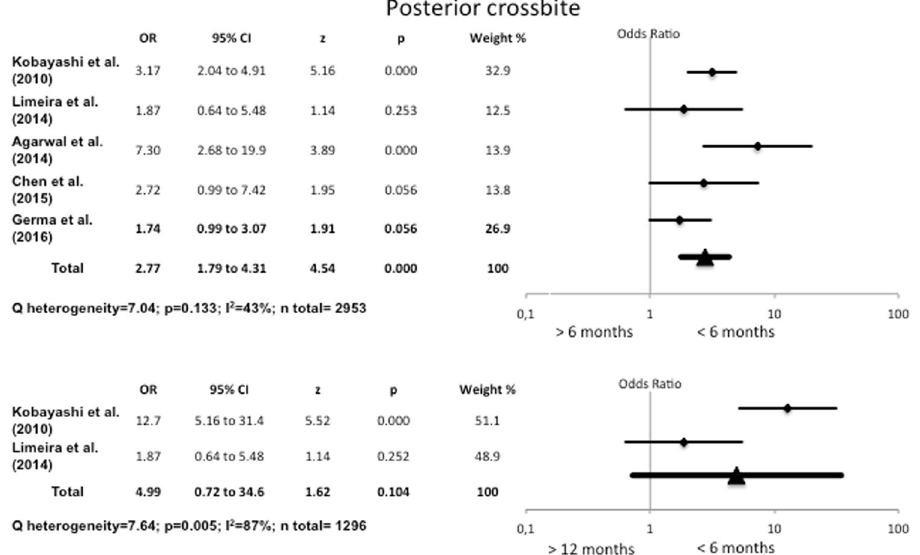
Figure 4. Odds Ratio for posterior crossbite, comparing breastfeeding for < 6 months with breastfeeding for > 6 months and > 12 months.